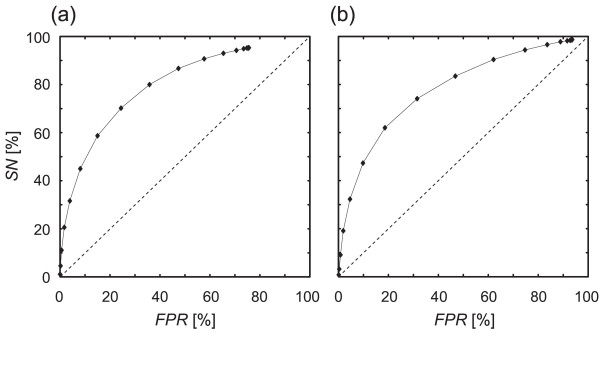
ROC curves for predictions by GC-skew peak. ROC curves for (a) Arabidopsis and (b) rice. The areas under the curves (AUCs) for ROC curves were 0.80 for Arabidopsis and 0.78 for rice. The diagonal lines in the two graphs correspond to the ROC curve produced by random prediction.